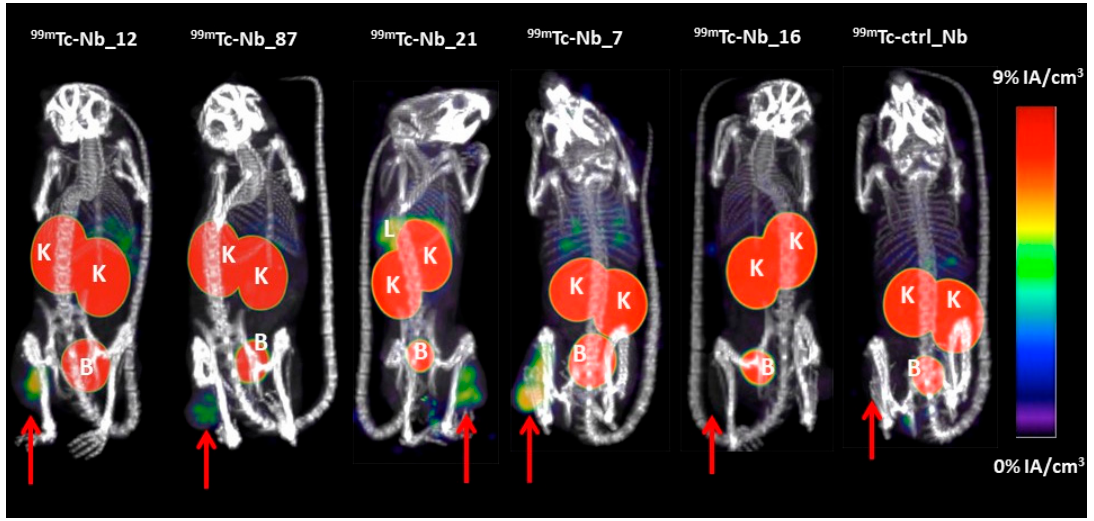
Figure 6. Biodistribution of 99m Tc-labeled anti-CD33 Nbs, and the non-targeting 99m Tc-ctrl_Nb in mice bearing THP-1 tumors. Micro-SPECT/CT images were obtained 1 h after intravenous injection of 99m Tc-labeled Nbs. Arrows indicate THP-1 tumors. K: kidney; B: bladder; and L: liver.